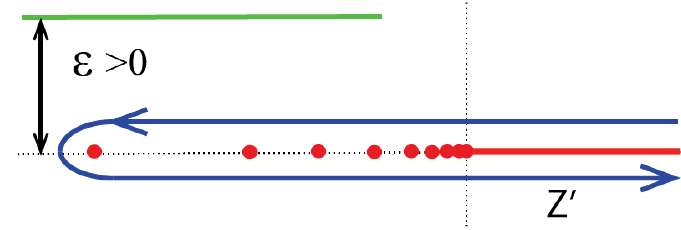
( E r + i ε − z (cid:48) ) g x ( z (cid:48) ) as a function of z (cid:48) with ε > 0. The operator Figure 3. The analytic structure of g y 1 1 ( z (cid:48) ) has a branch-cut on the [ 0, ∞ ) interval and accumulation of infinitely many bound states at zero g x 1 ( E + i ε − z (cid:48) ) has a branch-cut on the ( − ∞ , E + i ε ] interval. The contour C encircles energy, while g y 1 the spectrum of g x and avoids the singularities of g y . 1 1